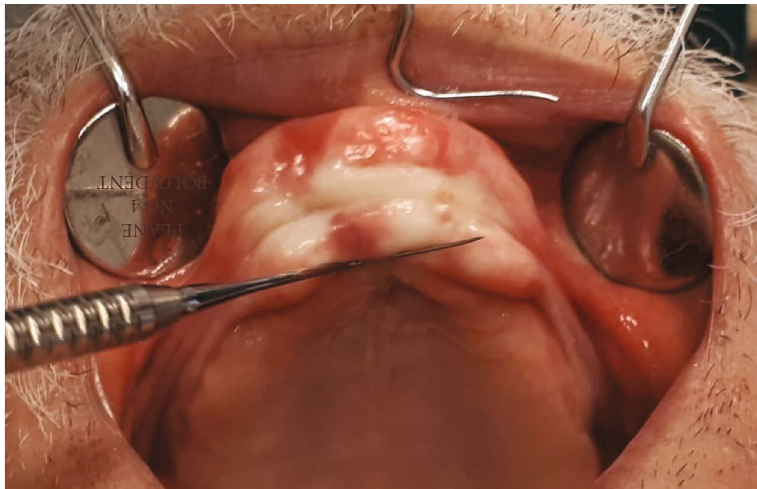
Figure 2: Intraoral fi ndings.